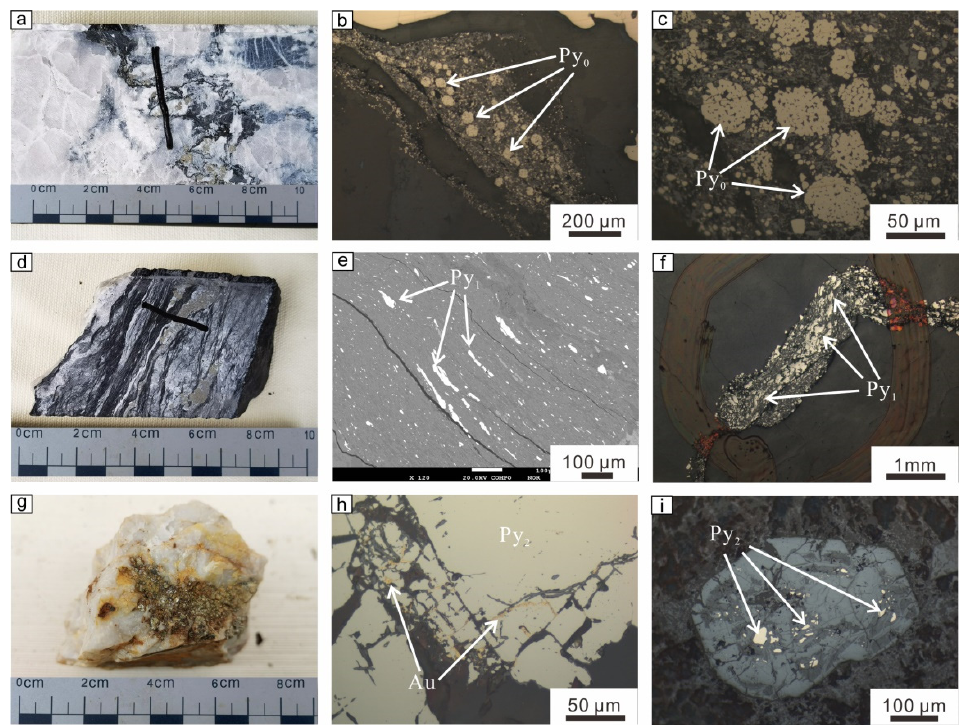
Figure 4. Photographs of three generations of pyrite from the Xinjazui gold deposit. ( a ) Quartz veins wrapped surrounding rock breccia in the ore-forming stage; ( b ) framboidal pyrite (Py0) in breccia of surrounding rock (reflected light); ( c ) framboidal pyrite (reflected light); ( d ) the pyrite quartz veins developed along the phyllite in the early stage of mineralization; ( e ) the pyrite (Py1) has elongated and drawn wire deformation and oriented arrangement (back scatter); ( f ) ductile shear deformation occurs in pyrite (Py1) (reflected light); ( g ) oxidized gold ores; ( h ) natural gold is embedded in the pyrite (Py2) fissures (reflected light); ( i ) pyrite is oxidized to hematite, which retains the pentagonal dodecahedron crystal form and forms skeleton crystal structure (reflected light).